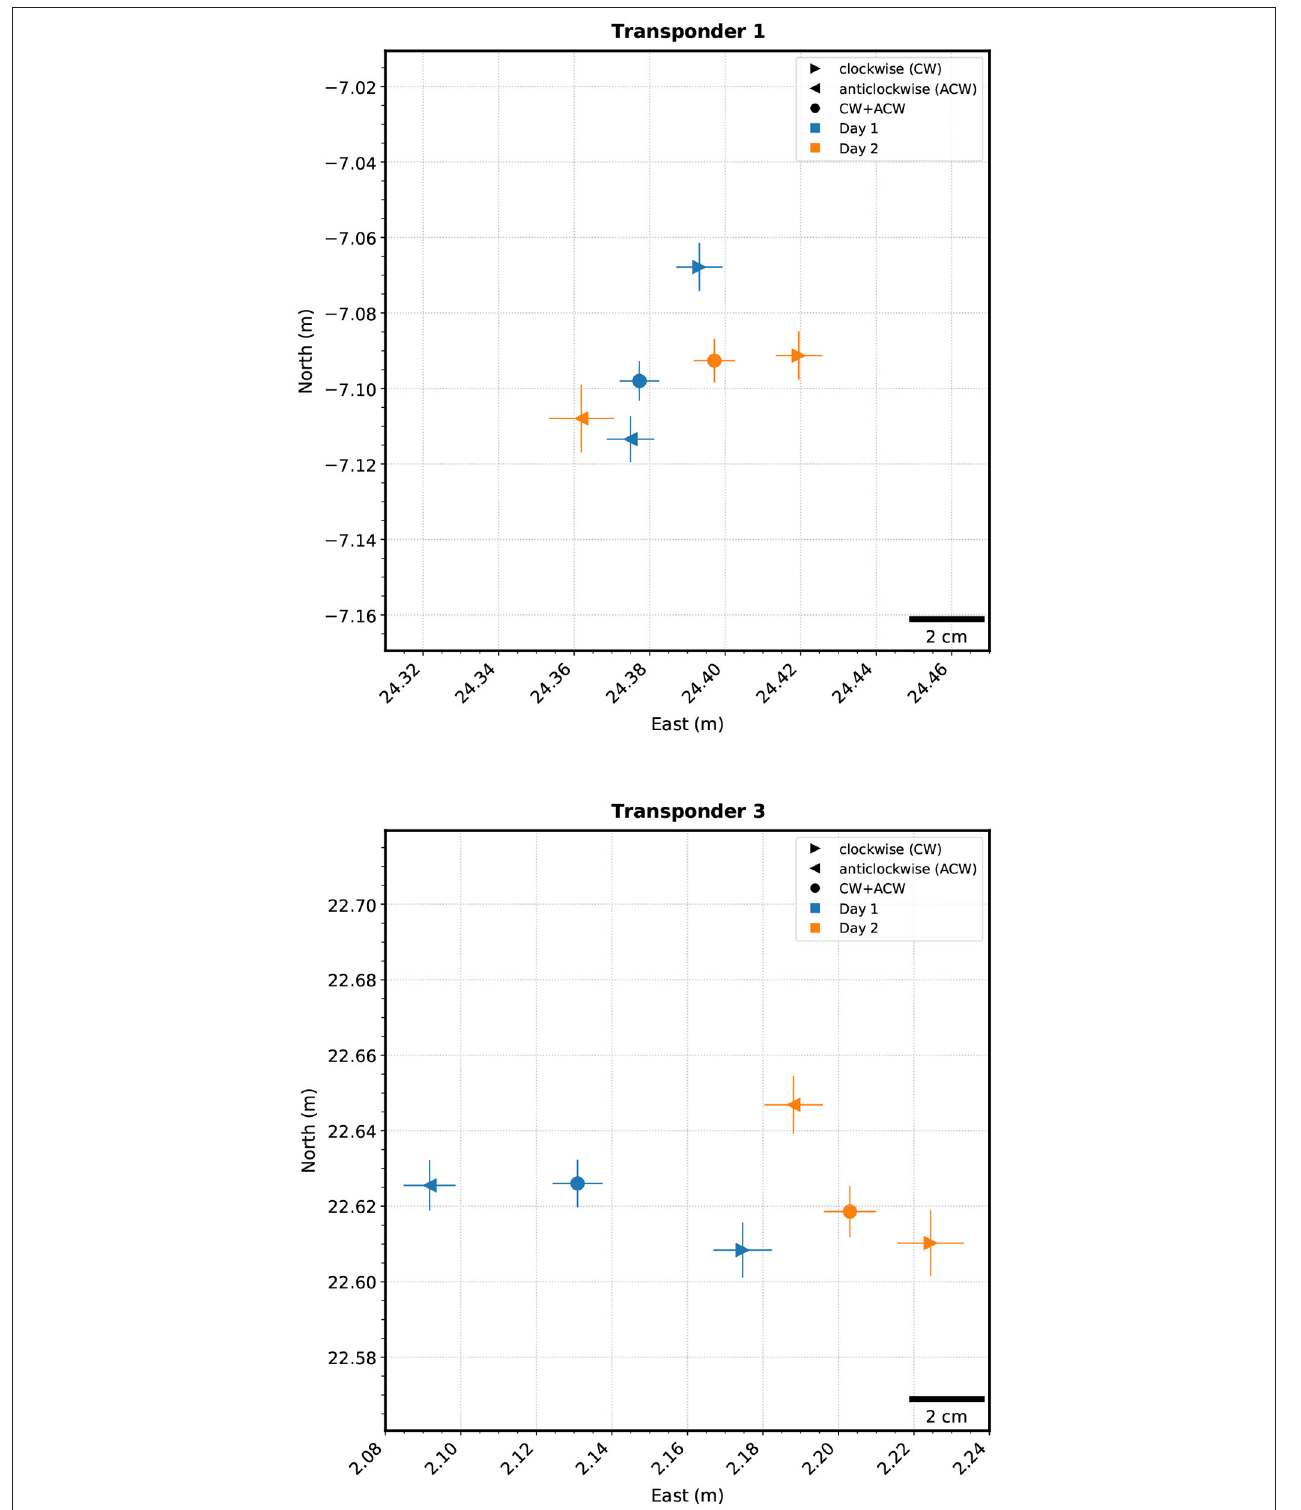
FIGURE 8 | Positions of transponders 1 and 3 based on a clockwise box-in ( ◮ ) and anticlockwise box-in ( ◭ ) for Day 1 and 2, compared to the result combining CW and ACW box-ins ( l ).